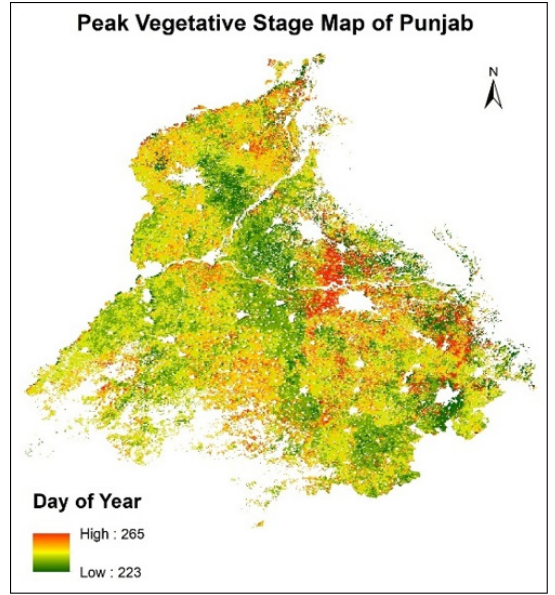
Figure 8: Peak vegetative stage of Haryana derived from MODIS NDVI data